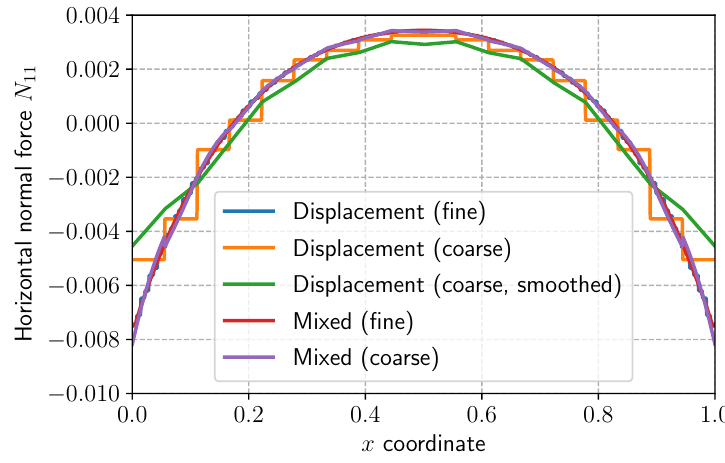
Figure 8. Horizontal membrane force N 11 [GN/m] for the thin plate case.